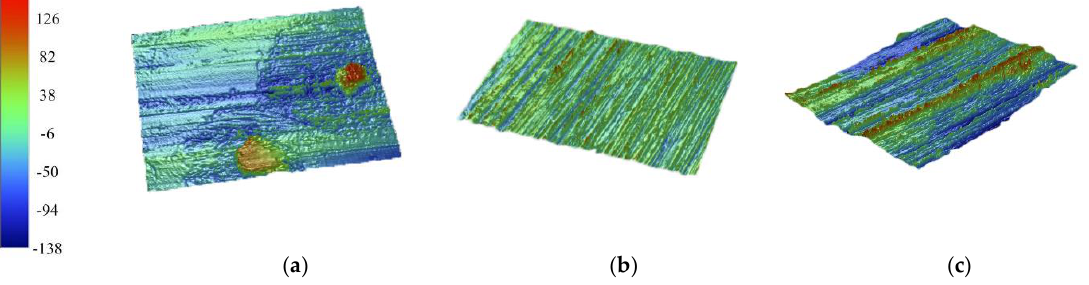
Figure 25. The surface roughness before processing: ( a ) Ra = 345.74 nm, ( b ) Ra = 203.61 nm, ( c ) Ra = 334.11 nm.